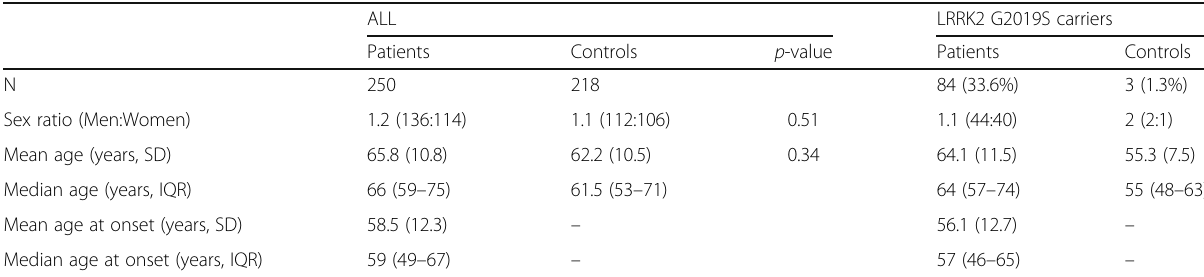
Table 1 Demographics of Patients and Control